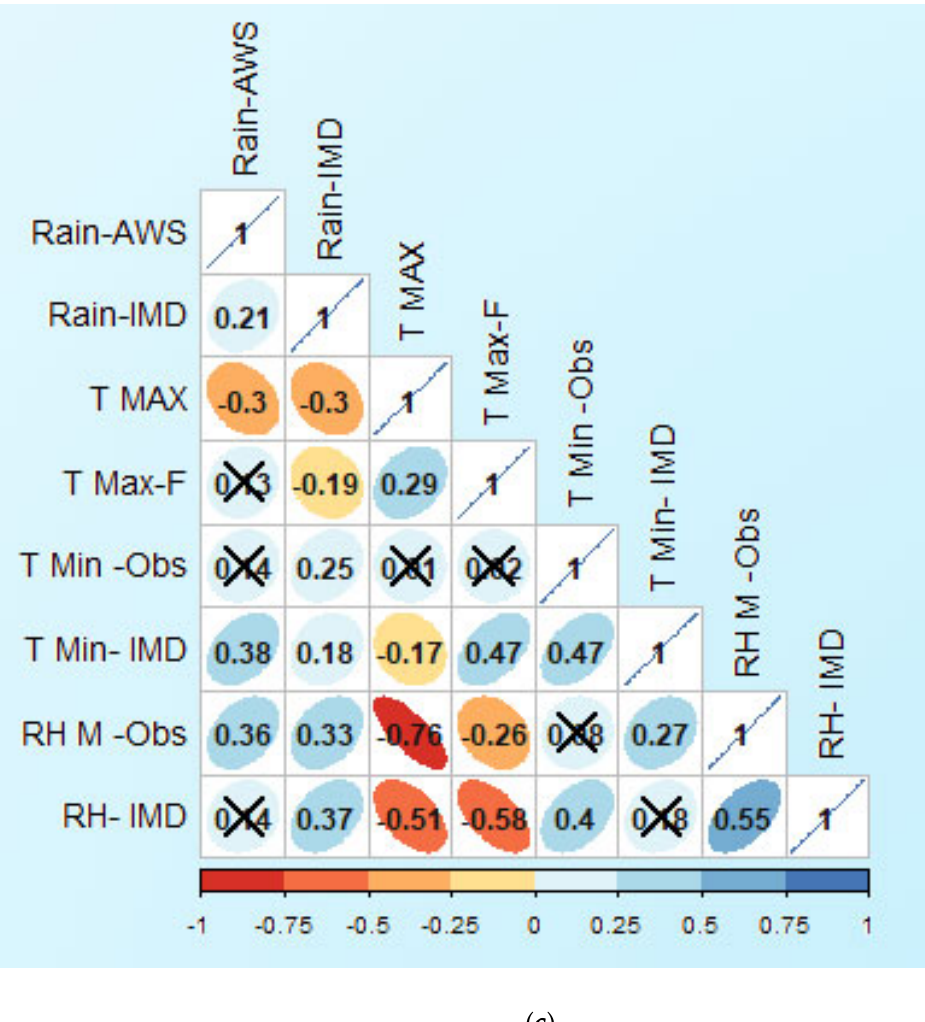
Figure 6. ( a ) Observed ‐ AWS vs. Forecasted TMax by IMD; ( b ) Observed RH by AWS vs. Forecasted RH by IMD; ( c ) correlogram of observed vs. forecasted variables. Correlogram of observed vs. forecasted weather, during Rabi , 2021–2022.